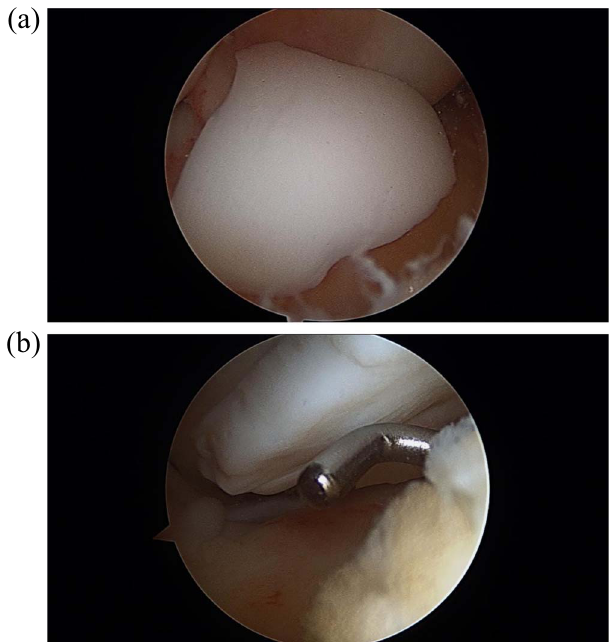
Figure 5. Intraoperative arthroscopic images showing the large loose chondral fragment. This was found in one large piece within the intercondylar notch, without underlying bony attachment (a and b).